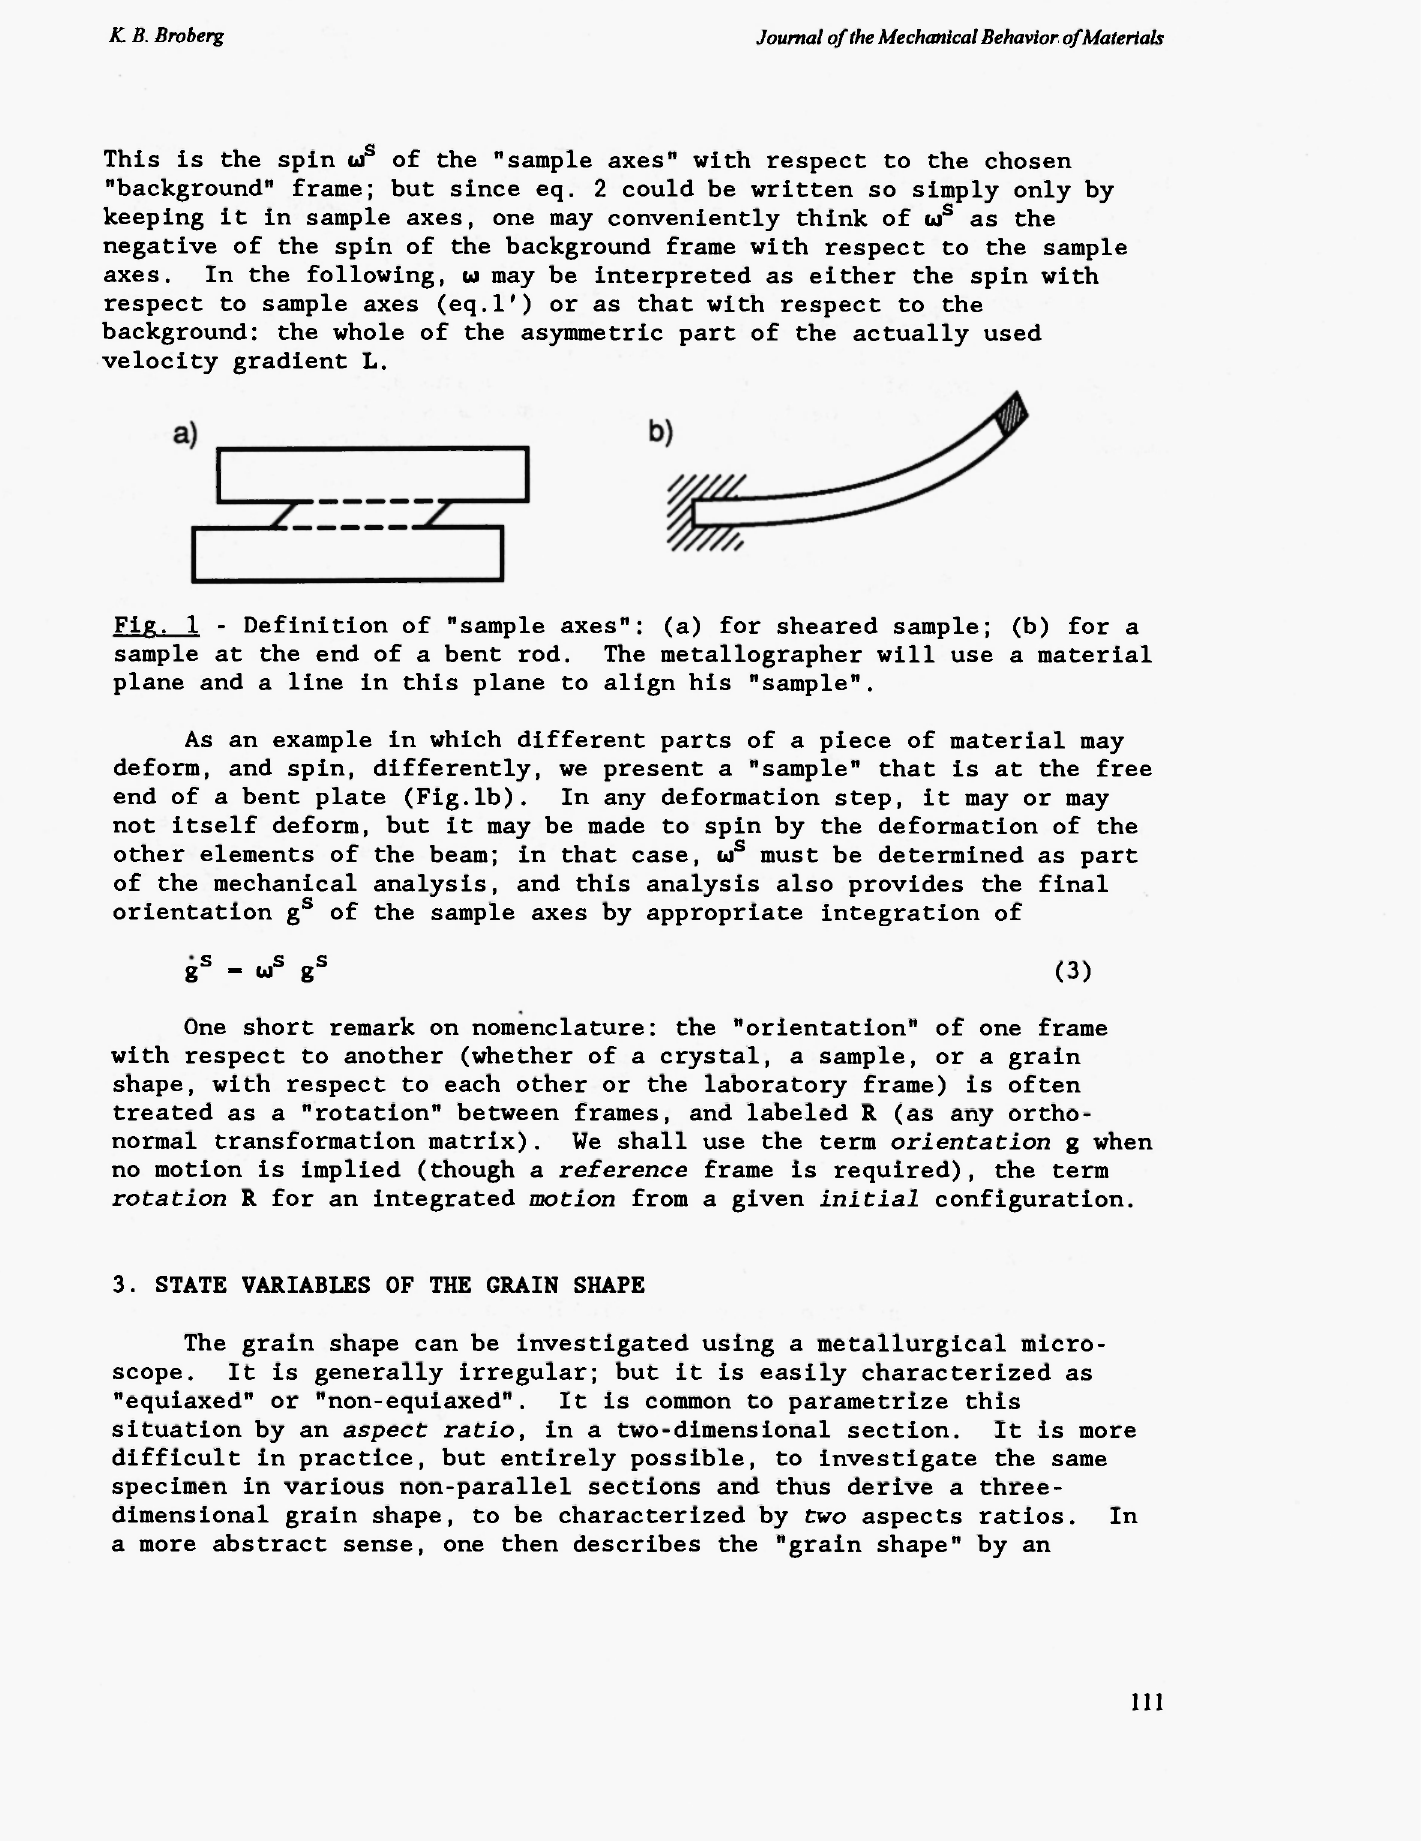
Fig. 1 - Definition of "sample axes": (a) for sheared sample; (b) for a sample at the end of a bent